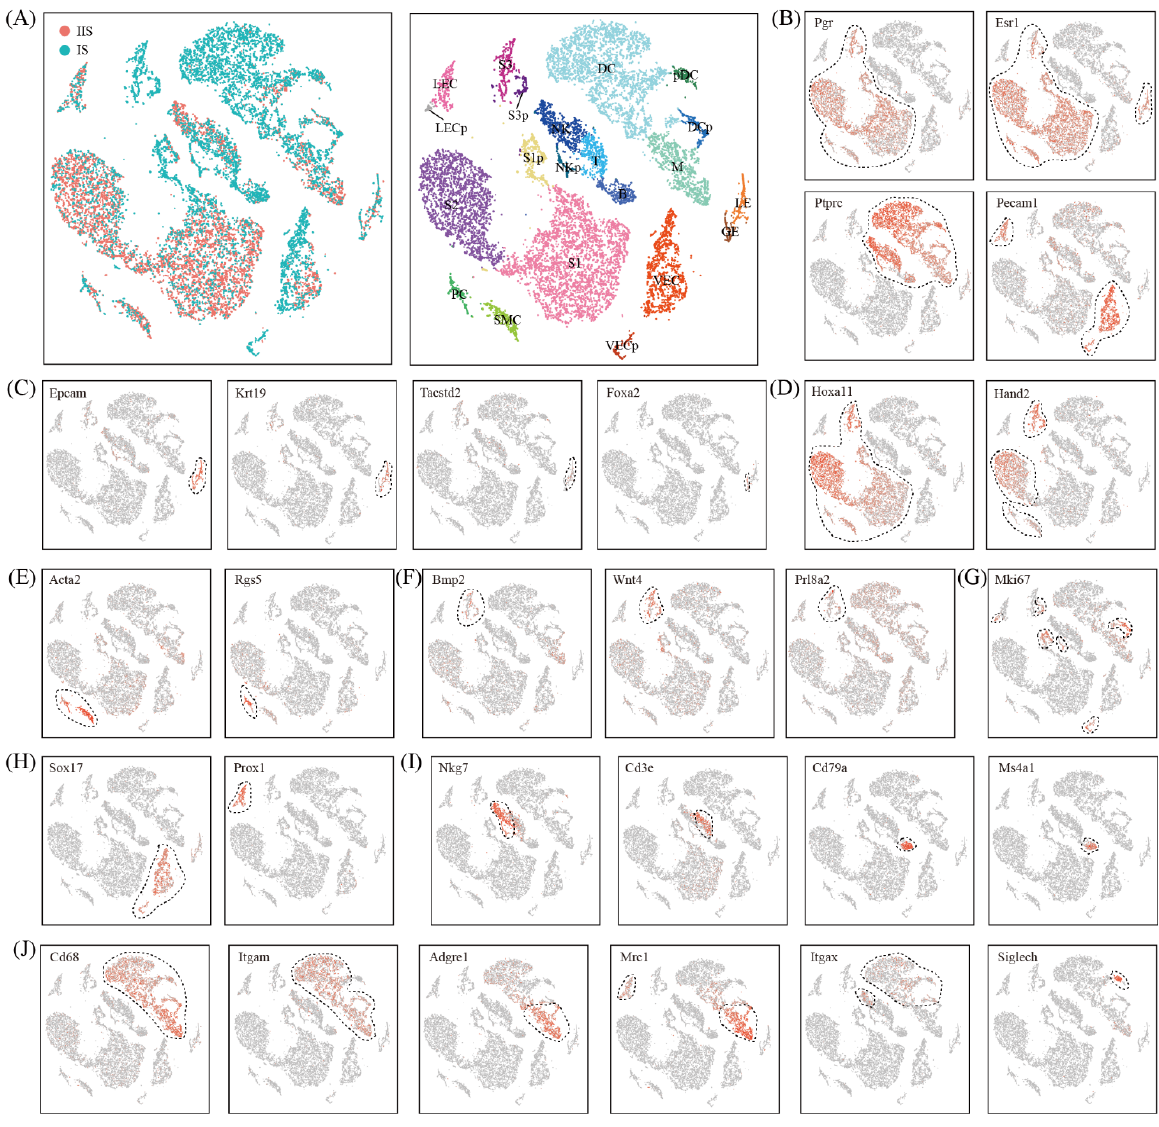
Figure 2. Identification of different cell types in mouse uterus by using canonical marker genes. ( A ) The t-Stochastic neighbor embedding (TSNE) representation of single-cell RNA-seq data obtained from IS and IIS of the uterus. Single cells were grouped by cellular origin (right) and cell clusters (left). LE, luminal epithelial cells; GE, glandular epithelial cells; S1, deep stromal cells; S1p, proliferating deep stromal cells; S2, superficial stromal cells; S3, decidual cells; S3p, proliferating decidual cells; SMC, smooth muscle cells; PC, pericytes; VEC, vascular endothelial cells; VECp, proliferating vascular endothelial cells; LEC, lymphatic endothelial cells; LECp, proliferating lymphatic endothelial cells; NK, natural killer cells; T, T cells; NKp, proliferating natural killer cells; B, B cells; M, macrophages; DC, dendritic cells; DCp, proliferating dendritic cells; pDC, plasmacytoid dendritic cells. ( B – J ) The expression pattern of canonical marker genes projected onto TSNE plots. Shown are pan-marker genes for hormone-responsive cells, immune cells and endothelial cells ( B ), epithelial cells ( C ), stromal cells ( D ), smooth muscle cells and pericytes ( E ), decidual cells ( F ), proliferating cells ( G ), endothelial cells ( H ), lymphocytes ( I ) and myeloid cells ( J ). Dashed lines denote the boundaries of the cell cluster of interest.